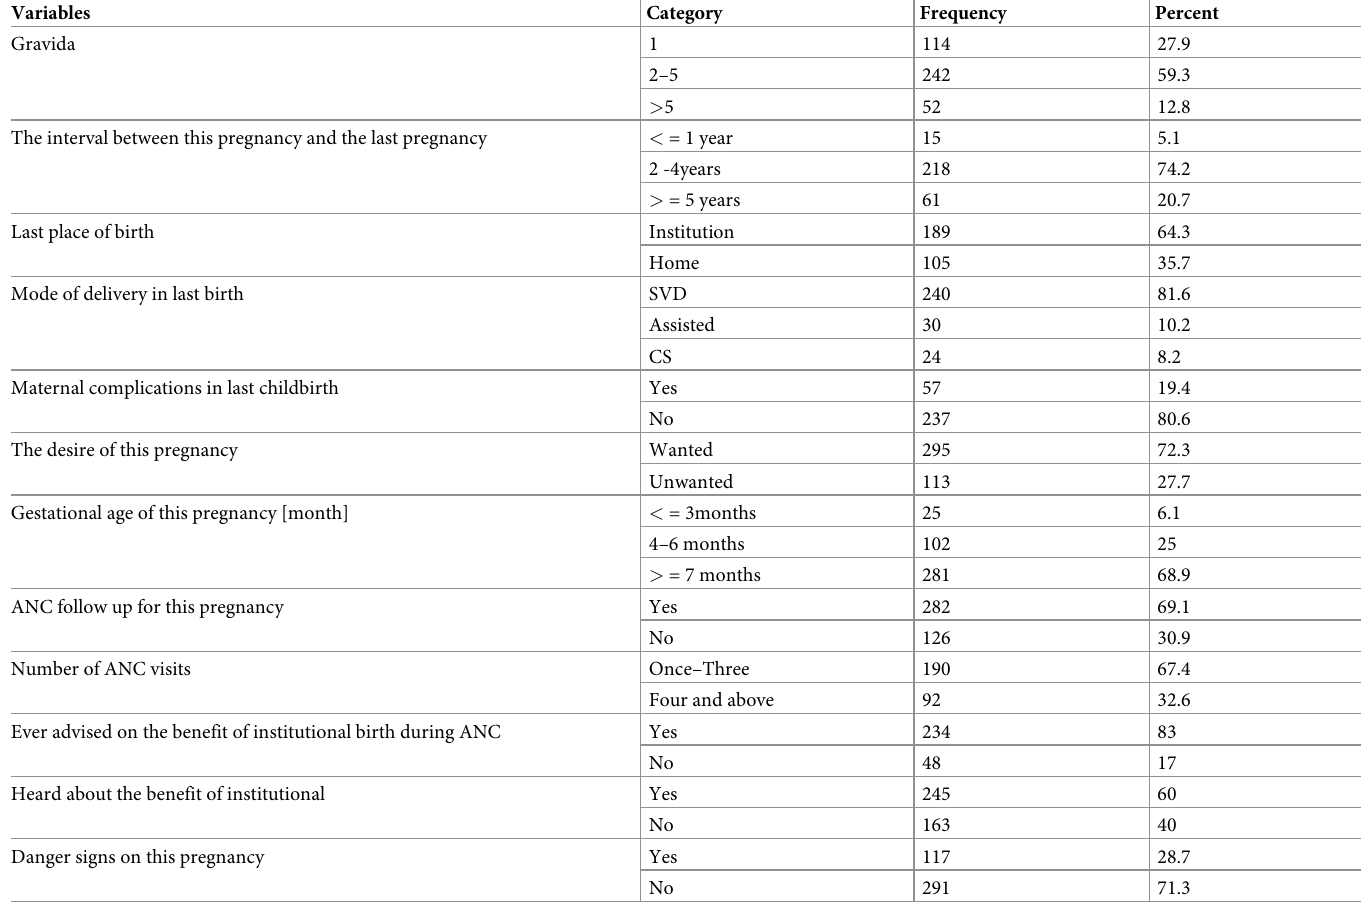
Knowledge about danger signs of pregnancy, labor, and following childbirth. Concern- ing the knowledge about danger signs, 201(49.3%) of the participants had good knowledge about danger signs. Severe headaches, absent of fetal movement, and loss of consciousness were the danger signs mainly reported by the participants (Fig 1). Table 3. Obstetrical characteristics of study participants in Arba Minch health demographic surveillance site, May 2021.